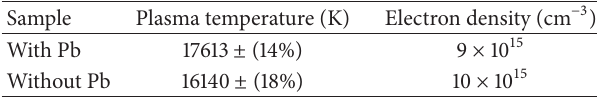
Table 1: Plasma temperature and electron density for both